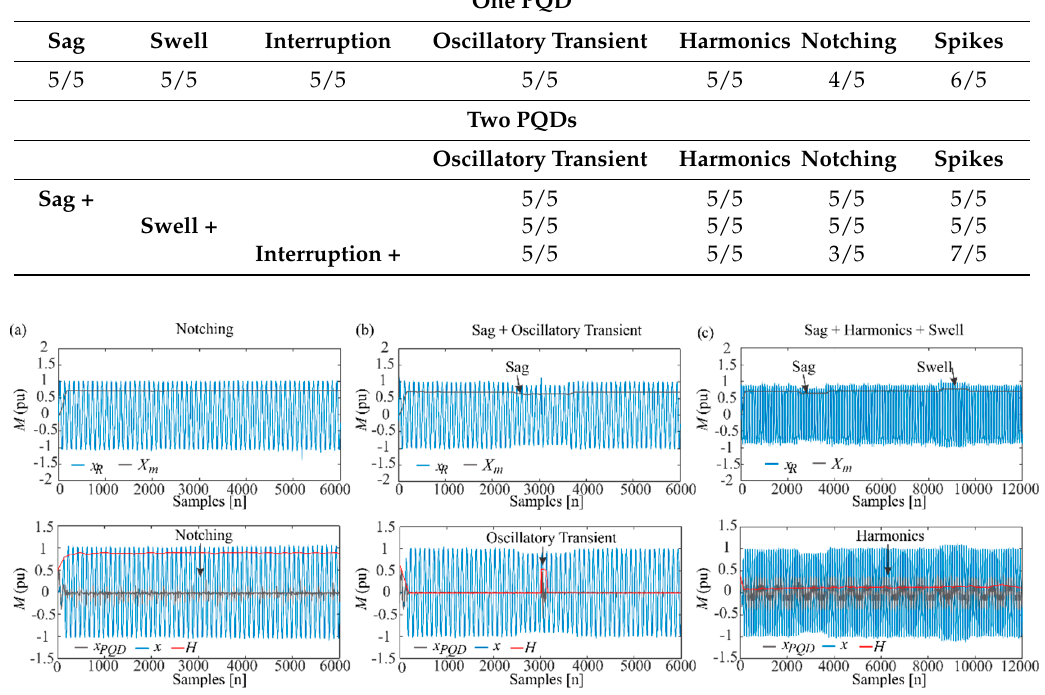
Figure 7. Real signals: ( a ) Notching, ( b ) Sag + Oscillatory transient, and ( c ) Sag + Harmonics + Swell. Table 3. Results for real signals.